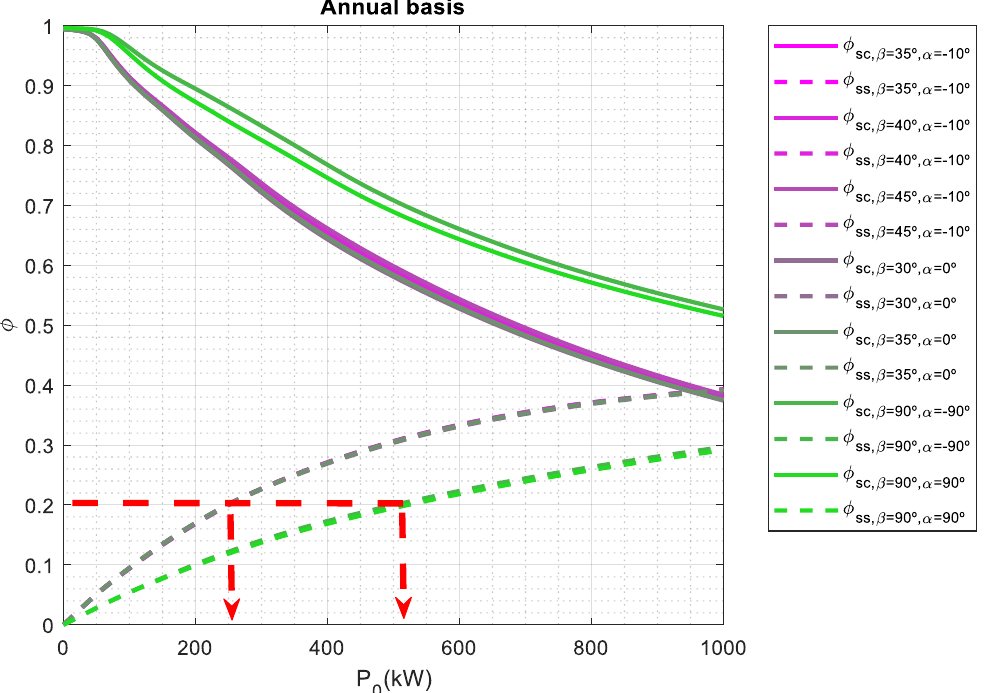
Figure 6. Annual basis. Φ sc and Φ ss curves which maximizes Φ ss. Figure 6 Annual basis. Ф sc and Ф ss curves which maximizes Ф ss.